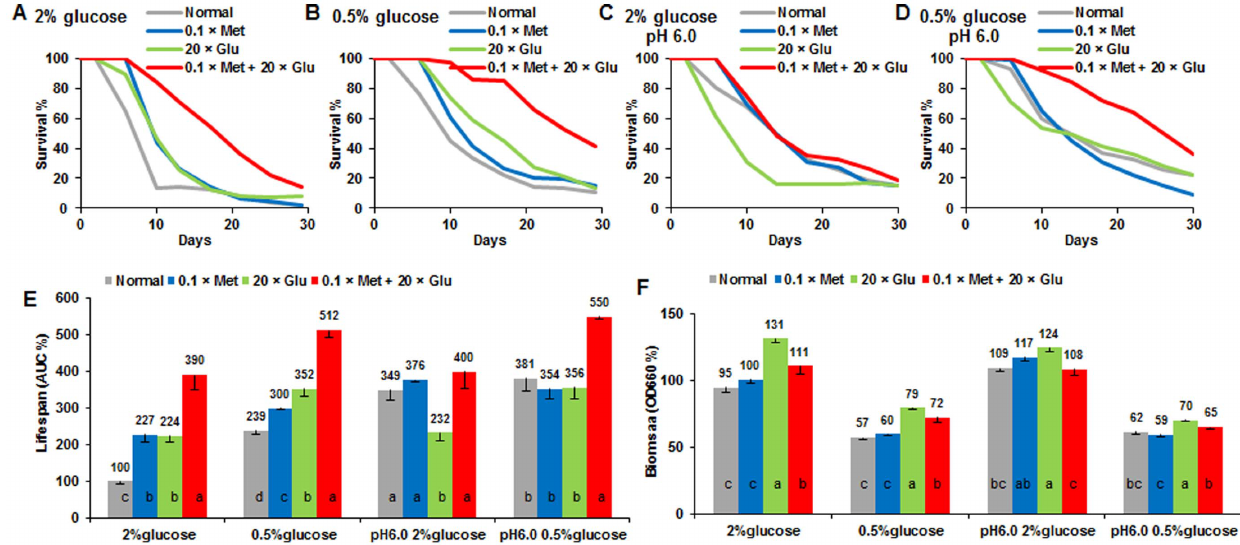
Figure 6. Independent and additive effects of glutamic acid, methionine and glucose on yeast lifespan extension. Survival curves of wild-type yeast were cultured in un-buffered normal (2% glucose, A ) and CR (0.5% glucose, B ) conditions or pH (6.0) buffered normal ( C ) and CR ( D ) conditions without (Normal/1E1N, control) or with low methionine (0.1 6 Met, 8 mg/L), high glutamic acid (20 6 Glu, 2 g/L) or a combination of both (0.1 6 Met + 20 6 Glu). CLS ( E ) and biomass ( F ) comparison of wild type yeast were grown in different media. The pH controlling was accomplished by citrate phosphate buffer solution (64.2 mM Na 2 HPO 4 and 17.9 mM citric acid, pH 6.0). AUC represents the survival integral for lifespan comparison. AUC or biomass of the un-buffered SD medium (1E1N with 2% glucose) was defined as 100%. Data were expressed as mean 6 s.e.m. (n=6) and compared using Duncan’s multiple range test at P , 0.05. Different lowercase letters in columns indicate significant difference.